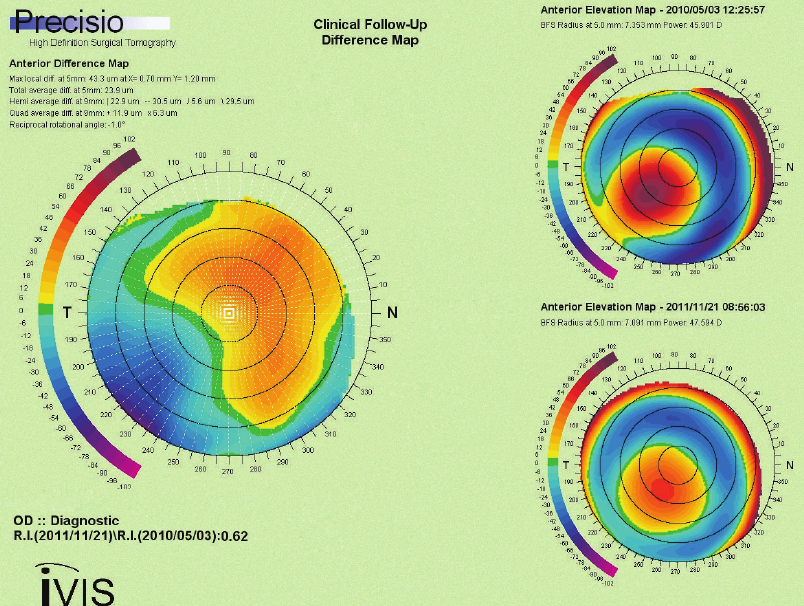
Figure 6: Scheimpflug anterior elevation di ff erence map showing depression at the cone and increased elevation orthogonally (left image). Scheimpflug anterior elevation maps (right images): preoperative (upper) and 12-months after epithelium-on CXL (lower).